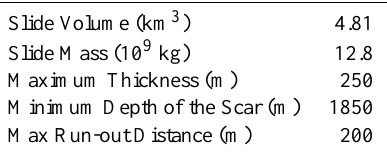
Table 4. Landslide parameters for the tsunami source 1693 L.